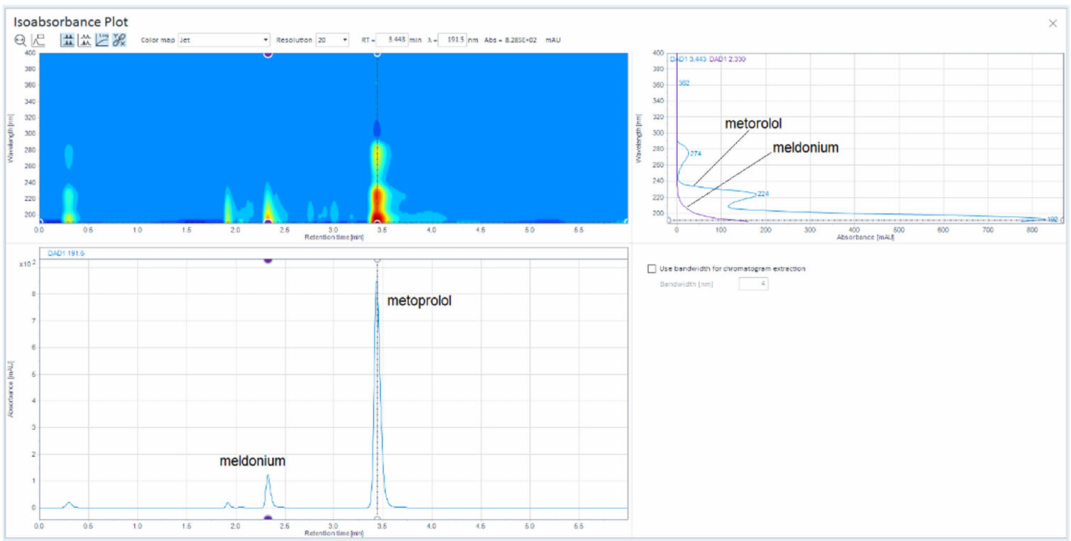
Figure 32. Full 3-D chromatogram of meldonium, extracted line at 197 nm and UV-spectrum of analytes with 50% ACN and 50% 13 mM NH 4 H 2 PO 4 using column Zorbax CN-SB-250 × 4.6 mm.